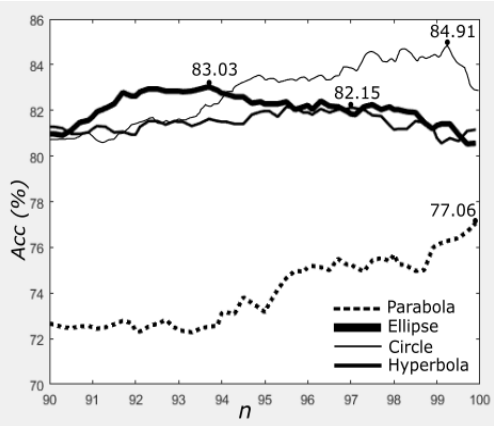
Figure 14. Quantitative results (MIAS dataset [18]) of LQP medium the fibro-glandular disk region on different neighbourhood topologies. Note that the x- axis and y- axis represent the accuracy (percentage of correctly classified cases) and the percentage of dominant patterns, respectively.